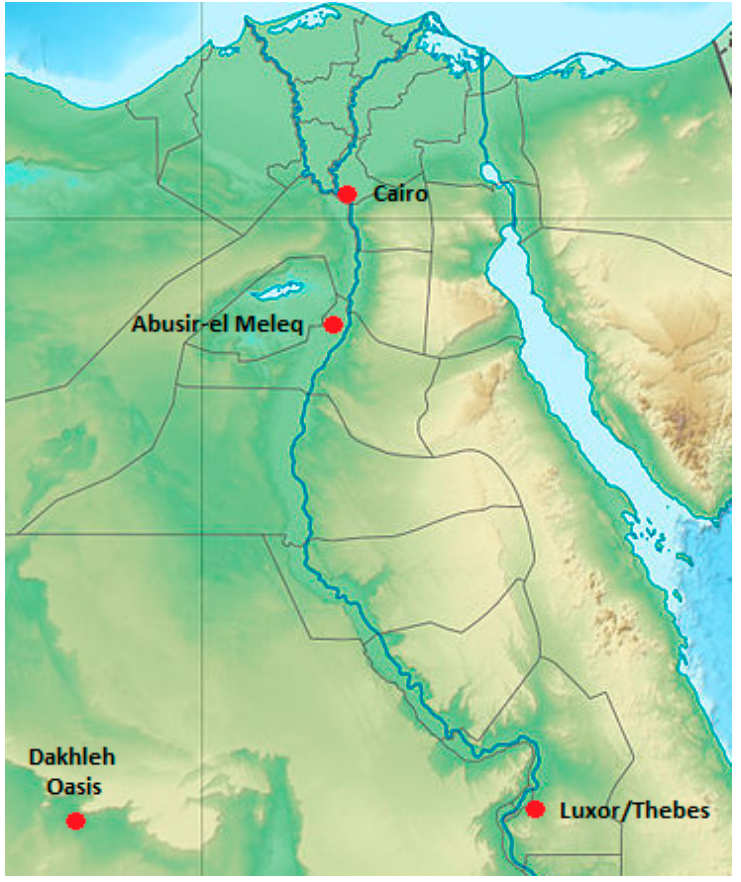
Figure 1. The 2000 km 2 Dakhleh Oasis in the Western Desert in Egypt. GPS coordinates: 25°29 ′ 29.6 ″ N, 28°58 ′ 45.2 ″ E.